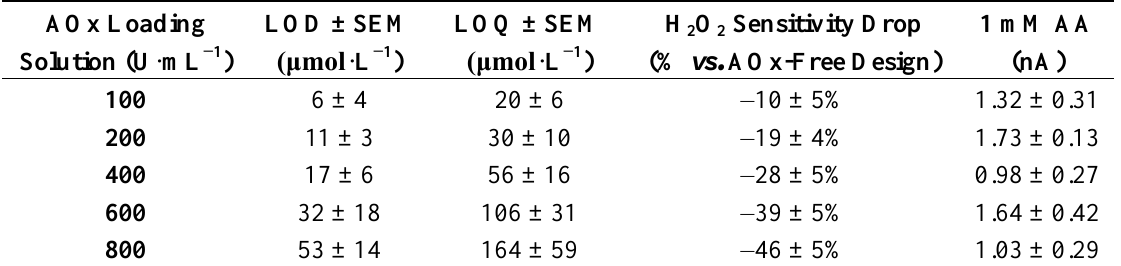
Table 2. In-vitro characterization of different biosensor configurations, with different enzyme loadings, at Day 1 ( n = 4 for each group) in terms of LOD and LOQ (Equations (4) and (5)), H O sensitivity decrease, and 1 mM AA 2 2